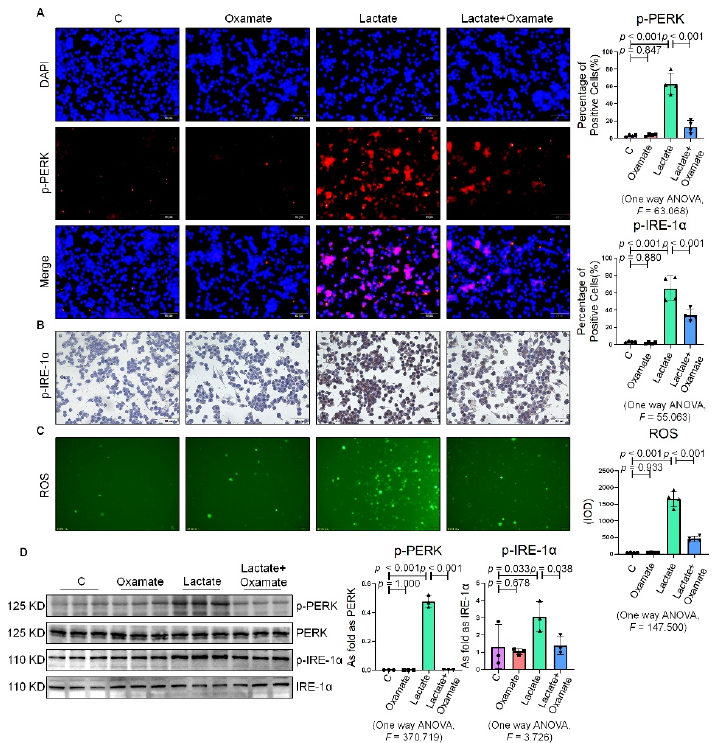
Figure 5. Oxamate attenuated the lactate-induced enhancement of ER stress in macrophages. ( A ) Expression of p-PERK in NR8383 cells observed by IF staining (scale bar = 50 µm). ( B ) Expression of p-IRE-1 α in NR8383 cells observed by IHC staining (scale bar = 50 µm). ( C ) Intracellular ROS production in NR8383 cells by using DCFH-DA staining (scale bar = 100 µm). ( D ) Protein expression of p-PERK and p-IRE-1 α in NR8383 cells treated with oxamate, lactate, and lactate plus oxamate measured by Western blotting. Data are presented as the mean ± SD, n = 3 per group.